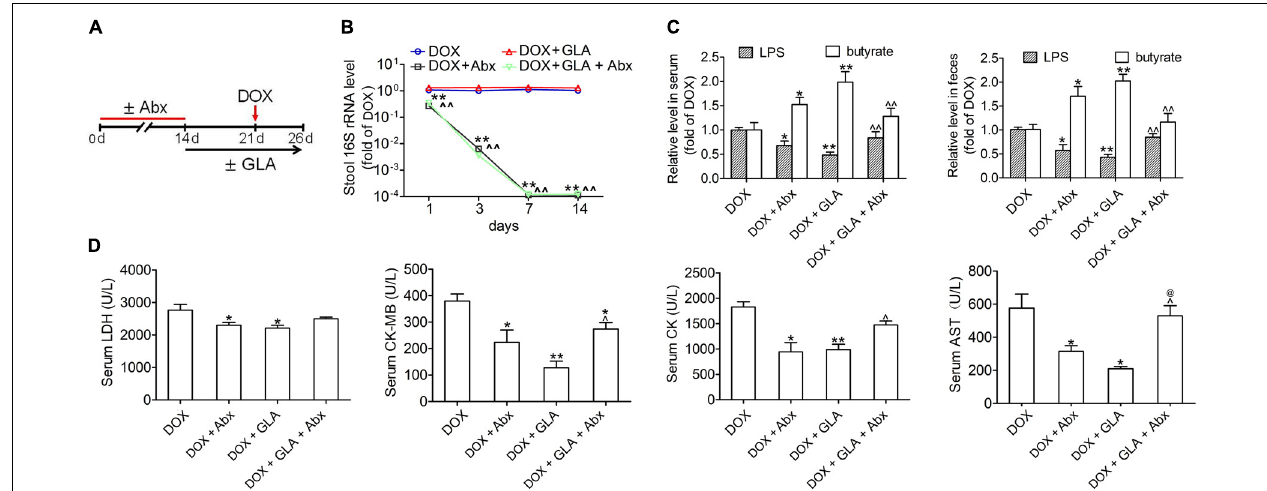
FIGURE 3 | Glabridin (GLA) prevents doxorubicin (DOX)-mediated cardiotoxicity though modulation of gut microbiota. The C57BL/6 mice from broad-spectrum antibiotics (Abx) and GLA (30 mg/kg) plus Abx groups were treated with a mixture of 0.5 g/L vancomycin, 0.5 g/L neomycin sulfate and 0.5 g/L primaxin in the drinking water for 2 weeks. After antibiotic treatment, a single dose of DOX (20 mg/kg) was intraperitoneal injected into the C57BL/6 mice to induce acute cardiotoxicity. GLA (30 mg/kg) or vehicle was intragastrically administered once daily for 12 days, starting 7 days before DOX injection. (A) Schematic representation of the experimental approach. (B) The efficacy of Abx to remove gut bacteria was confirmed by quantifying stool bacterial load ( n = 10). (C) The levels of Lipopolysaccharide (LPS) and butyrate levels in feces and peripheral blood were determined by Limulus Amebocyte Lysate (LAL) assays or high performance liquid chromatography (HPLC), respectively ( n = 10). (D) Serum levels of LDH, CK-MB, CK and AST ( n = 10). The values are presented as the mean ± SEM. ∗ P < 0.05, ∗∗ P < 0.01 vs. DOX, ˆ P < 0.05, ˆˆ P < 0.01 vs. DOX + GLA, @ P < 0.01 vs. DOX +